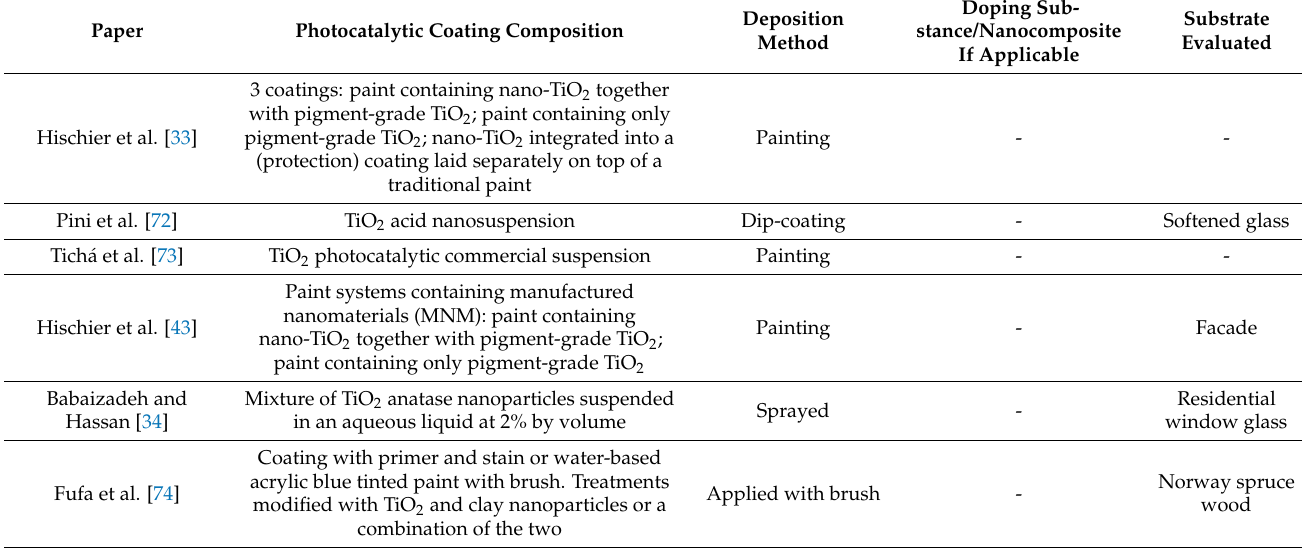
Table 3. Papers with results assessed for sustainability and life cycle assessment (LCA). The entry “-“ is for information unavailable or not